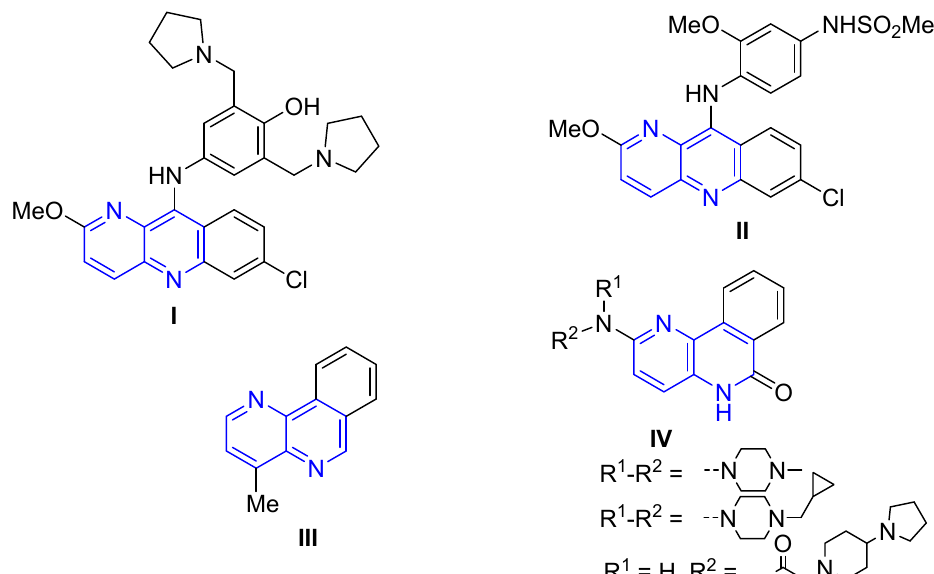
Figure 1. Fused naphthyridines with biological applications.